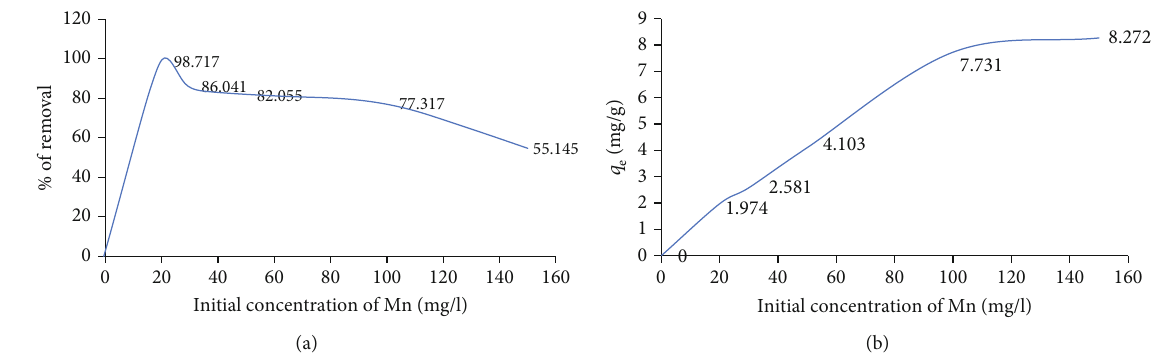
Figure 8: E ff ect of the initial concentration of Mn(II) on (a) % removal and (b) adsorption capacity.